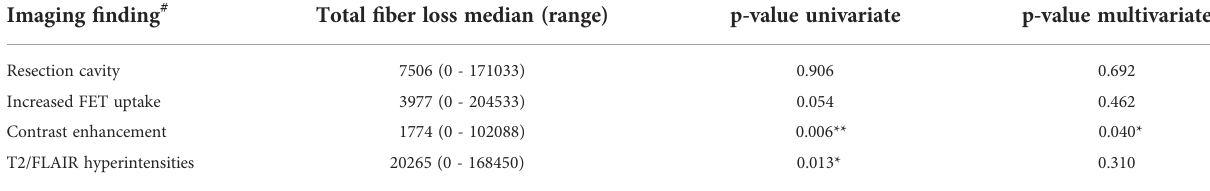
TABLE 3 Results of logistic regression analyses for the impact of total fi ber loss on general performance status (normal ECOG=0 vs. impaired ECOG ≥ 1). Imaging fi nding